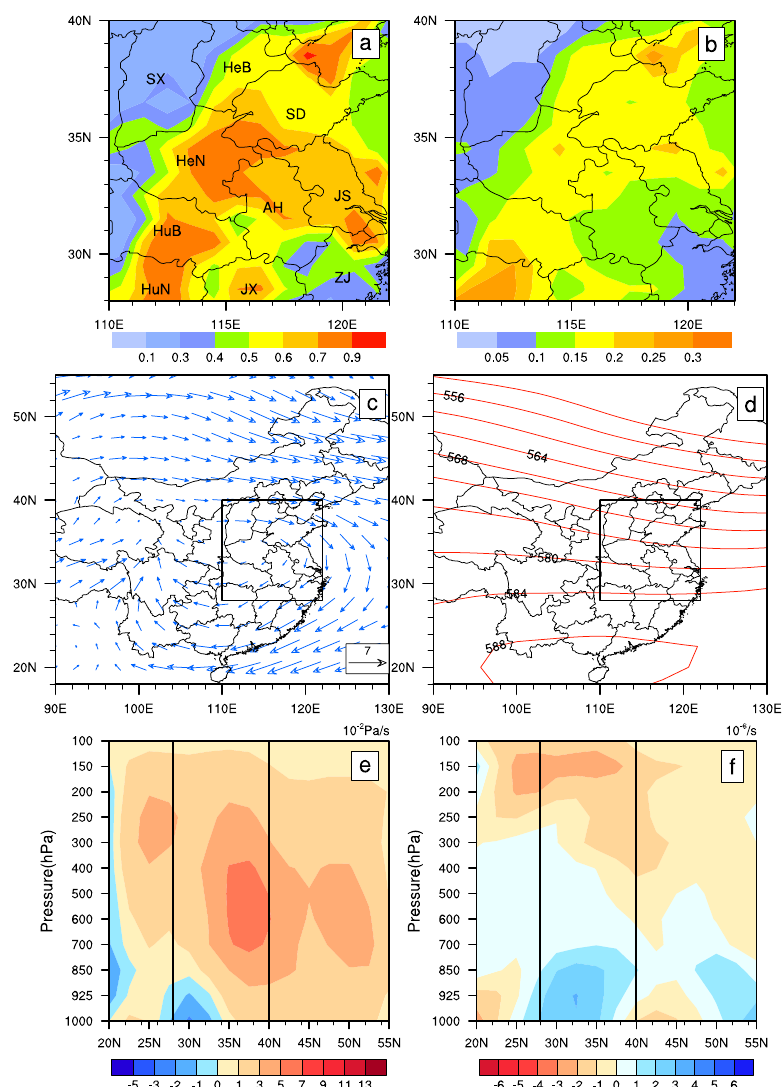
Figure 1. The mean distribution of (a) aerosol optical depth (AOD), (b) the standard deviation of AOD, (c) 850hPa winds field, (d) 500hPa geopotential height field, (e) height–latitude cross-sections of vertical velocity (10 − 2 Pas − 1 ) and (f) divergence of winds (10 − 6 s − 1 ) aver- aged from longitude of 110–122 ◦ E in October for the period from 2001 to 2010. Black letters on Fig. 1a indicate the different provinces. SX: Shanxi; SD: Shandong; HeB: Hebei; HeN: Henan; HuB: Hubei; HuN: Hunan; AH: Anhui; JX: Jiangxi; JS: Jiangsu; ZJ: Zhejiang. Note: (c) – (f) indicate the circulations over East Asia (18–55 ◦ N, 90–130 ◦ E) and black rectangular regions in this and subsequent figures represent eastern China (28–40 ◦ N, 110–122 ◦ E), the region on which this study is